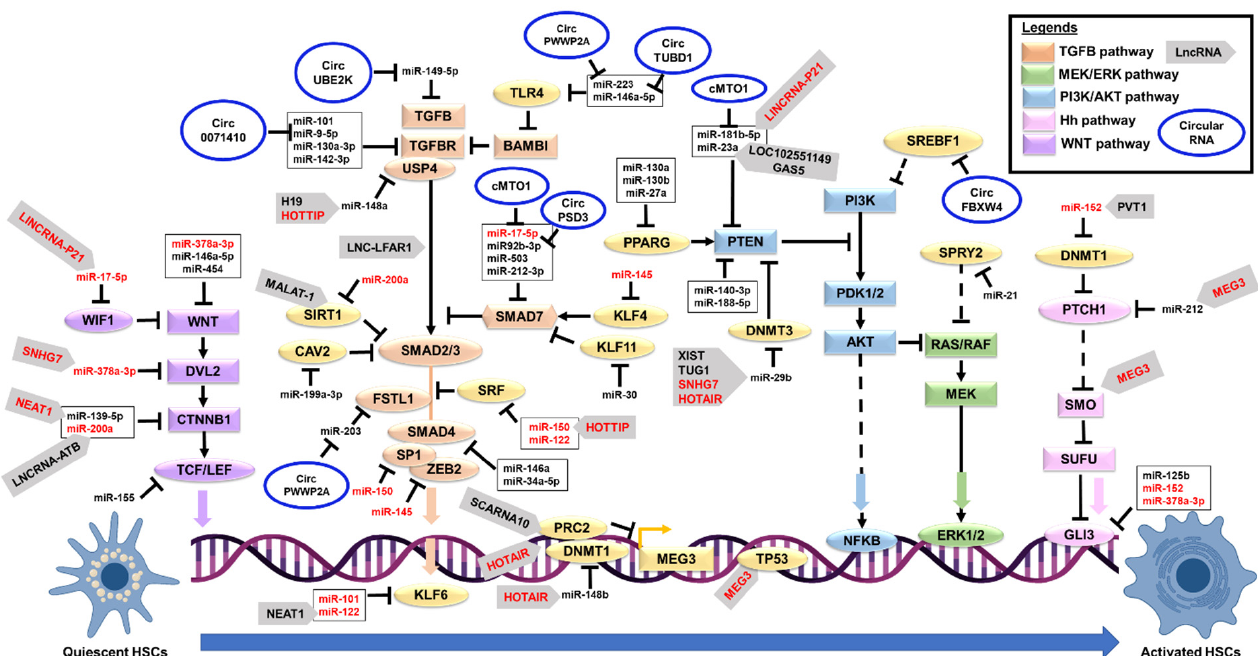
Figure 1. A schematic diagram showing the molecular regulation of hepatic stellate cells activation. Represents the positive regulation, ┴ represents the negative regulation, dashed line represents indirect regulation, and red color text represents multiple target regulation. Abbreviations: AKT: AKT serine/threonine kinase; Circ: Circular; ERK: Extracellular signal-regulated kinase; Hh: Hedgehrog; HSC: Hepatic stellate cells; MEK: dual-specificity mitogen-activated protein kinase; LncRNA: Long noncoding RNA; PI3K: Phosphatidylinositol-3 kinase; TGFB: Transforming Growth Factor Beta; WNT: